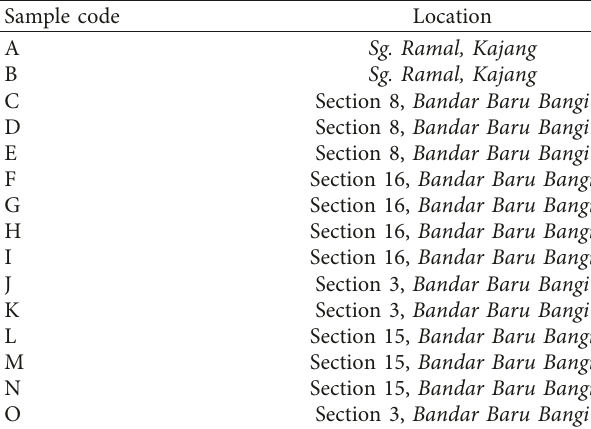
Table 1: The selected 15 paid water filters located in Bandar Baru Bangi , Selangor, Malaysia. Sample